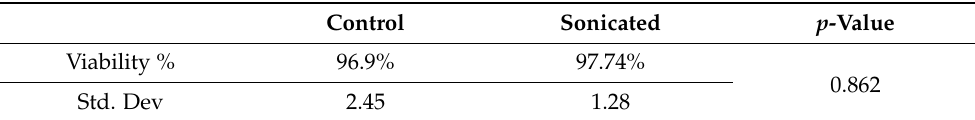
Table 1. Cell viability following 60 s of sonication using LFUS (35